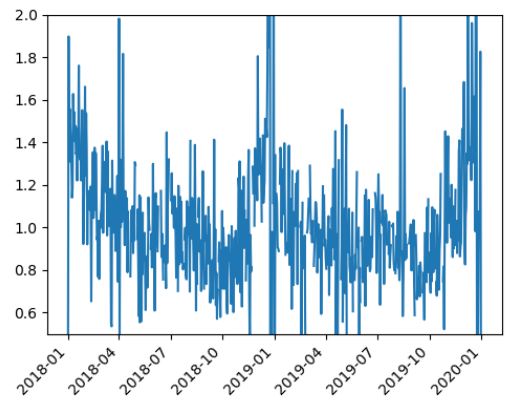
Figure 15. Parkings and seasonality. Green: higher occupancy during winter (+58%). Red: higher occupancy during summer (+18%).